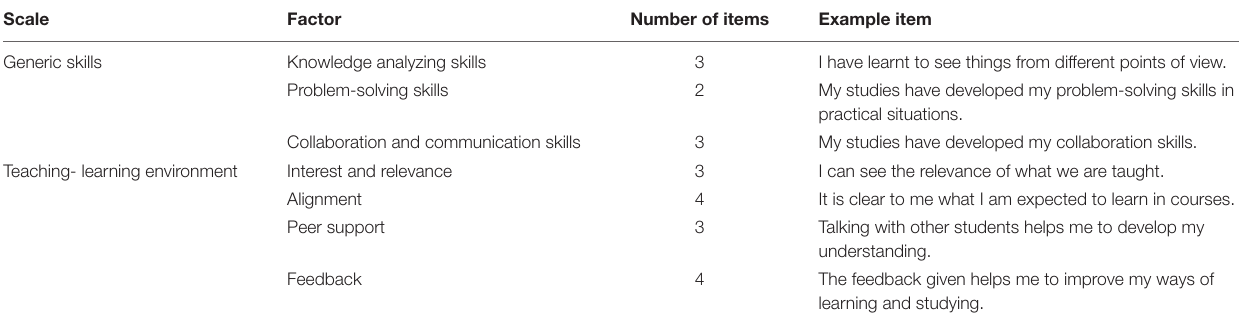
TABLE 2 | The scales, factors, number of items and an example item for each factor. Scale Factor Number of